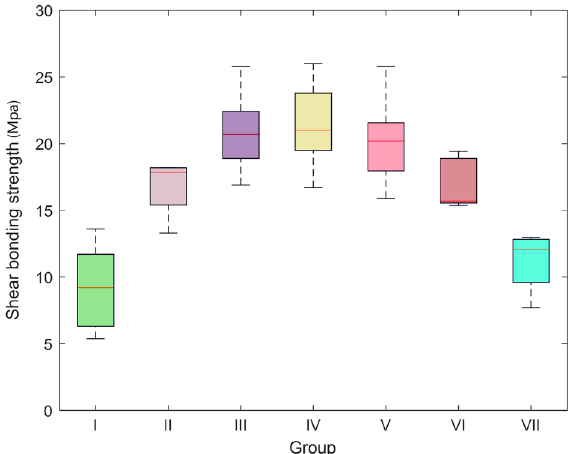
Figure 4. Boxplot diagram of SBS by group. See Table I for group description.